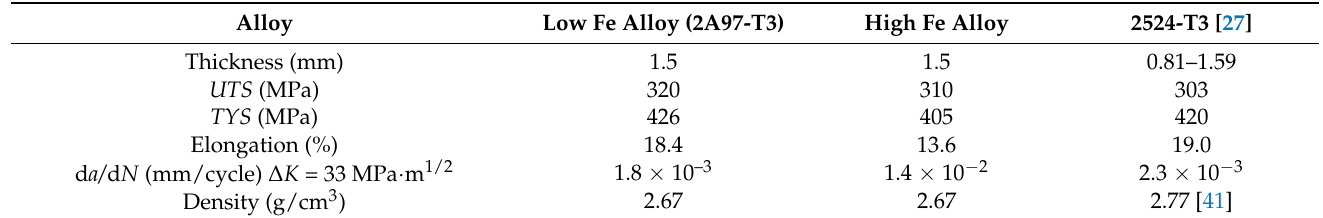
Table 2. Typical mechanical properties and density for Al-Cu-Li-Zr alloys and the 2524-T3 alloy. Alloy Low Fe Alloy (2A97-T3)